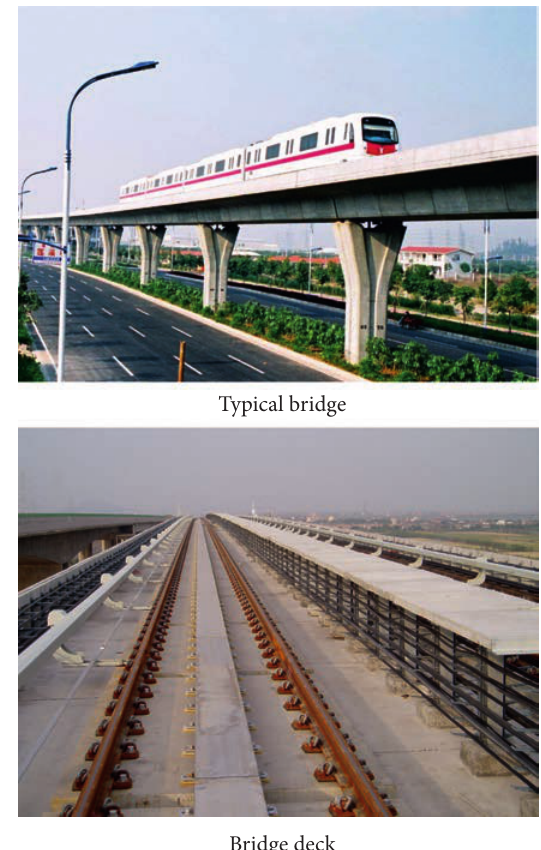
Fig. 2. The LIM elevated bridge of Guangzhou metro line